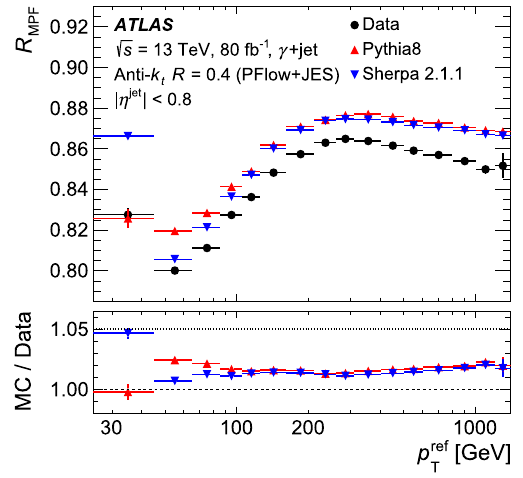
Fig. 12 Average PFlow jet response as a function of reference p T for γ +jet events calculated using the MPF technique. The black points correspond to 2015–2017 data. The red and blue triangles correspond to independent Monte Carlo samples from two different generators. Error bars show the statistical uncertainties. The ratio of MC simulation to data for both generators is shown in the bottom panel and defines the in situ correction to be applied. The dotted lines at 1 and 1.05 serve as a